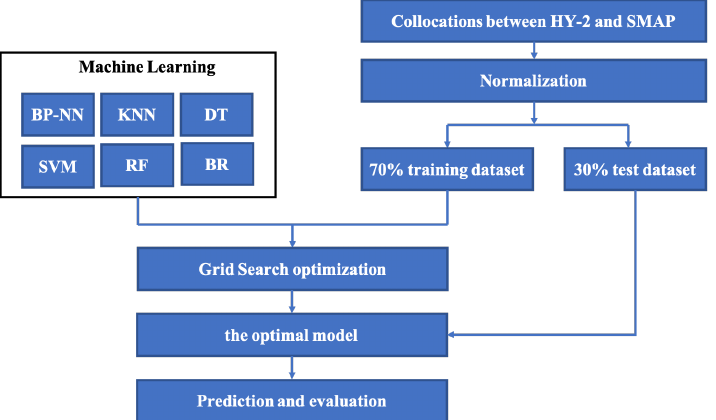
Figure 1. Methodology for revising the high wind speed of HY-2B/C/D